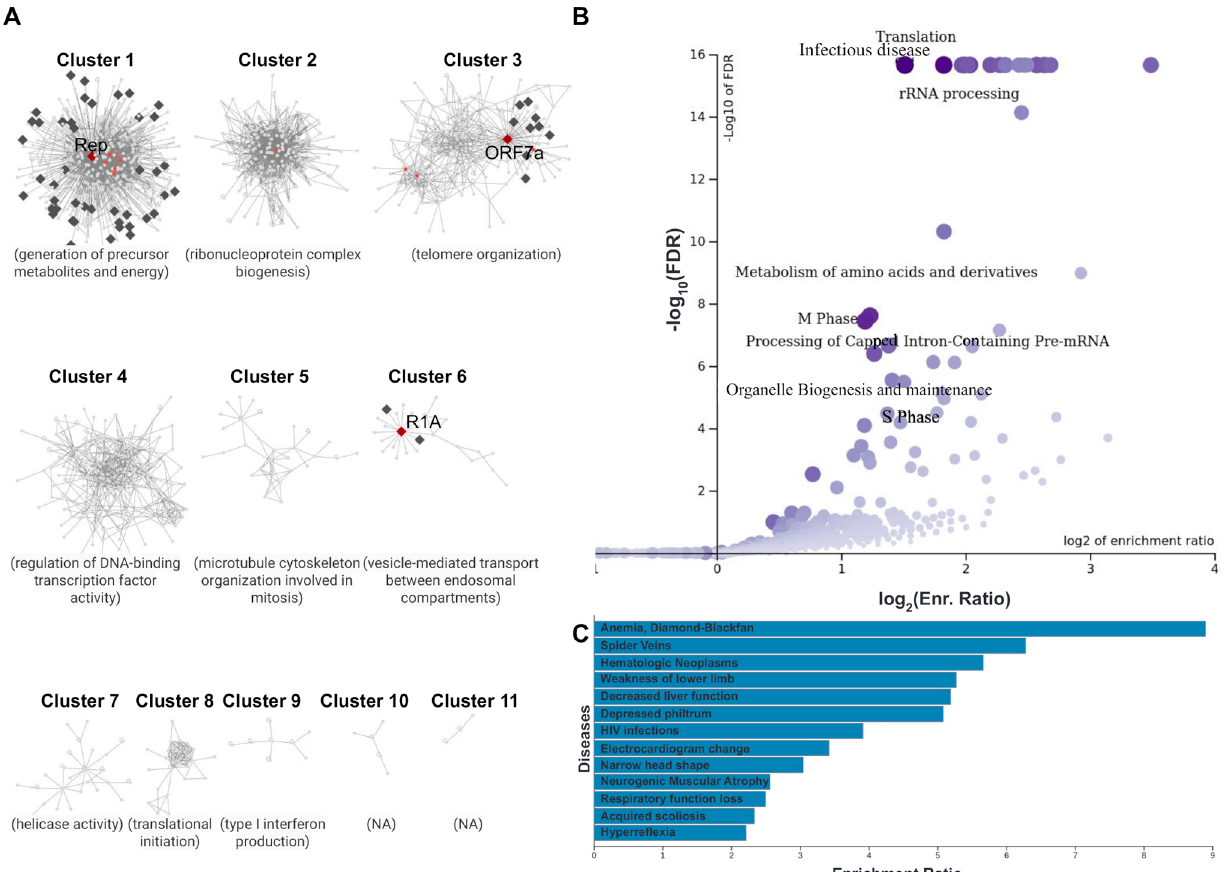
Figure 5. ( A ) The SARS-CoV-2–human interactome at the level of the nuclear envelope. The clustered network is shown. Proteins localized at locations of the NE (either human or viral) are shown as diamonds ( ♦ ), while proteins from other locations are shown as circles. Human proteins are colored dark gray for NE proteins and light gray for other interactors, while SARS-CoV-2 proteins are colored dark red for NE-localized proteins and bright red for other viral proteins. The labels of the three NE-localized viral proteins (R1A, ORF7a, and Rep) are shown. Each cluster is annotated with its top-ranking GO biological process term. ( B ) Functional enrichment with Reactome metabolic pathways. Enrichment results are shown in the form of a volcano plot. ( C ) Top disease associations produced from enrichment.